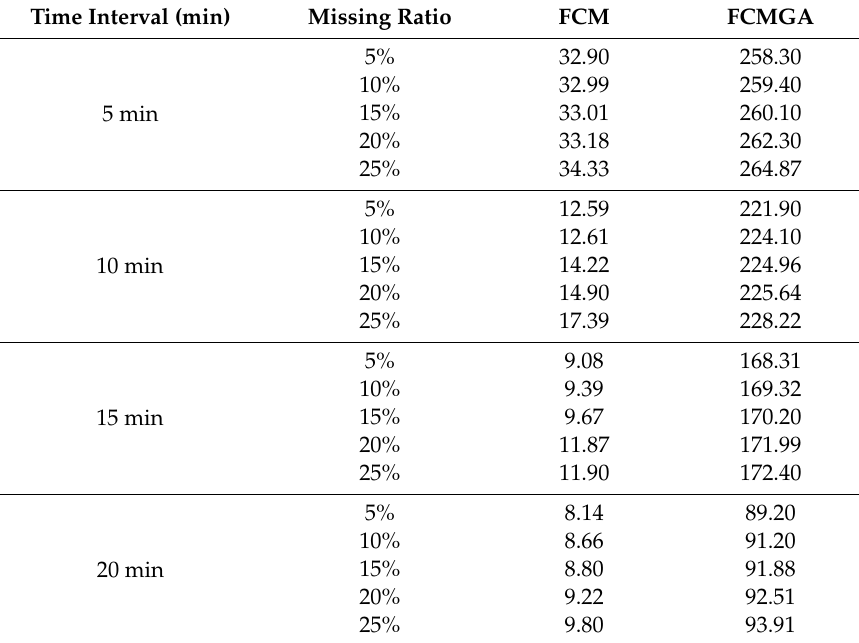
Table 4. Average computation time of FCM and FCM-GA (in